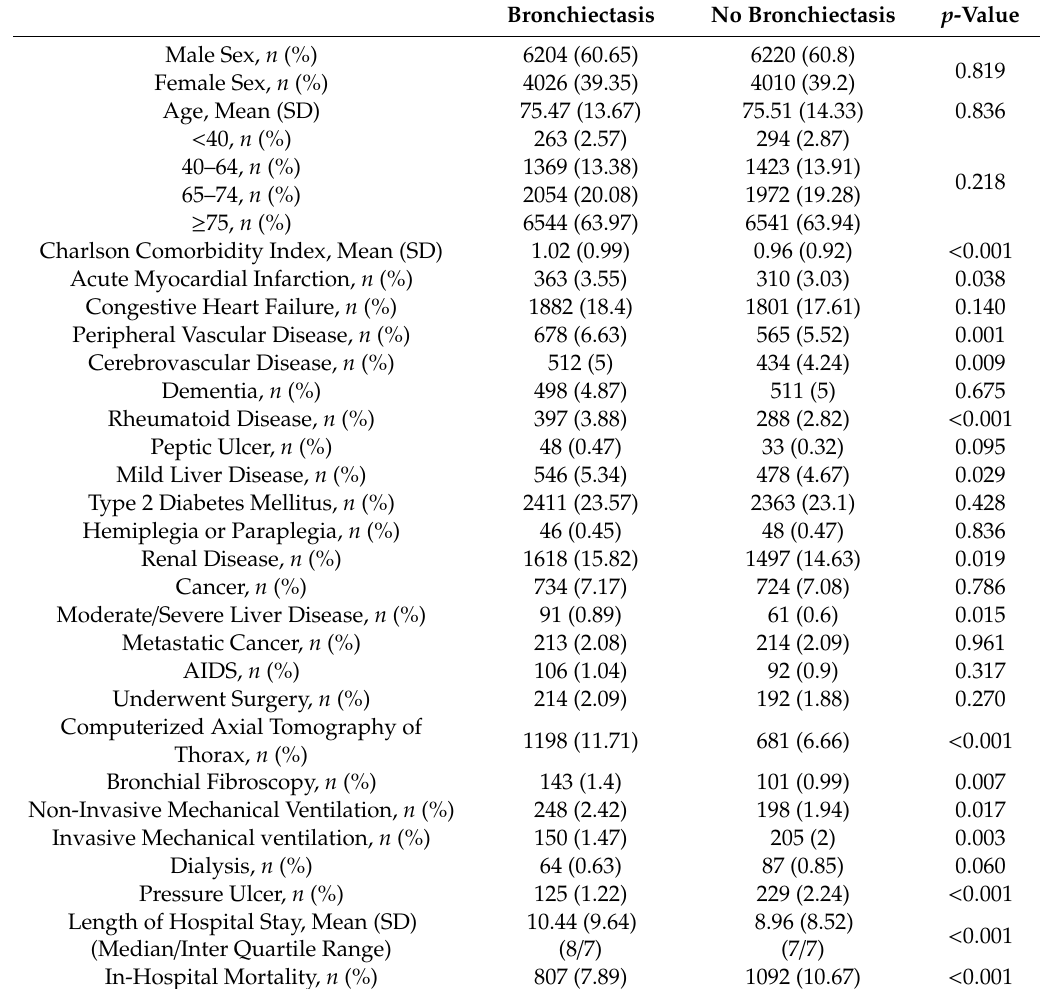
Table 2. Distribution of study variables and hospital outcomes of patients with and without bronchiectasis hospitalized with community-acquired pneumonia (CAP) in Spain (2016–17), after propensity score matching.